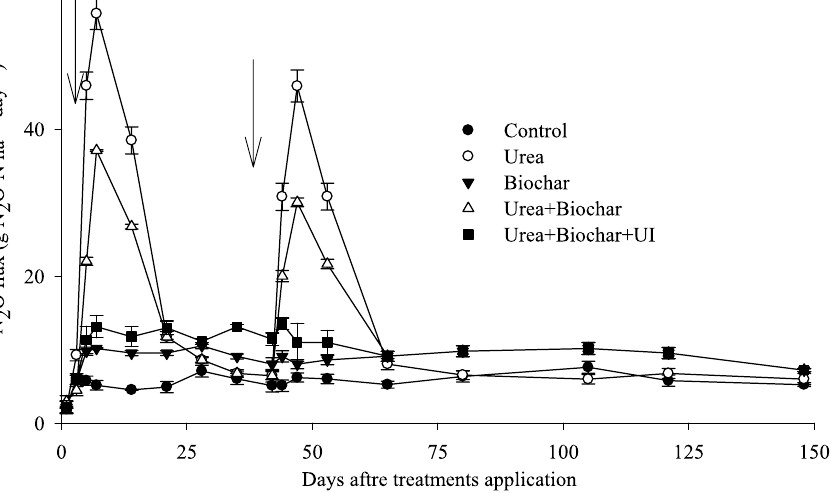
Figure 3. Soil N 2 O flux in response to nitrogen application with and without biochar and/or urease inhibitor. Bars on means represent SE for n = 4. The arrows show time of N application.